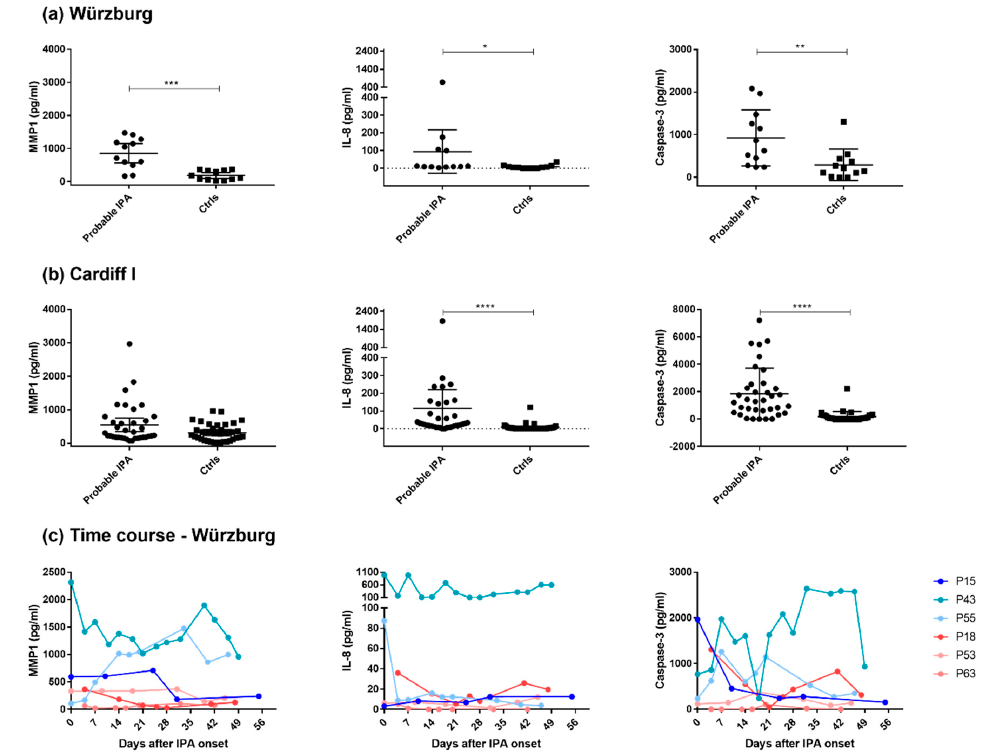
Figure 4. Serum protein levels of MMP1, IL-8, and caspase-3 investigated in probable IPA cases and their matched controls. Protein levels of potential candidates were investigated in ( a ) an original profiled patient cohort obtained from the University Hospital of Würzburg ( n = 6), ( b ) a patient cohort (Cardiff I) obtained from Public Health Wales Microbiology Cardiff, United Kingdom ( n = 12), and ( c ) original profiled patient cohort (Würzburg) samples collected up to 56 days after IPA onset ( n = 6) (IPA cases in blue, control patients in red shades). Data in ( a , b ) are shown as mean protein levels with 95% confidence intervals. Significant differences among investigated cases and controls were determined by the Mann–Whitney test (* p < 0.05, ** p < 0.01, *** p < 0.001, **** p < 0.0001). n , number of patients.